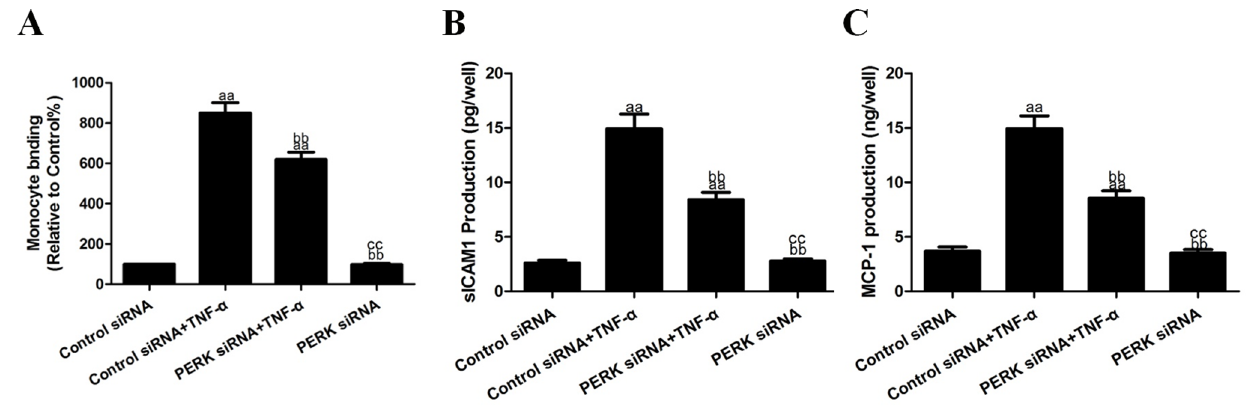
Figure 6. Effects of PERK siRNA on TNF- a -induced inflammatory cytokines in cell culture supernatants. A. The adhesion of U937 monocytes to HUVECs. B. The levels of sICAM1 production in cell culture supernatants. C. The levels of MCP-1 production in cell culture supernatants. The results are expressed as the means ¡ SD, n 5 6. aa P , 0.01, compared with the control siRNA group; bb P , 0.01, compared with the control siRNA + TNF- a group; cc P , 0.01, compared with the PERK siRNA + TNF- a group. EP, ethyl pyruvate.